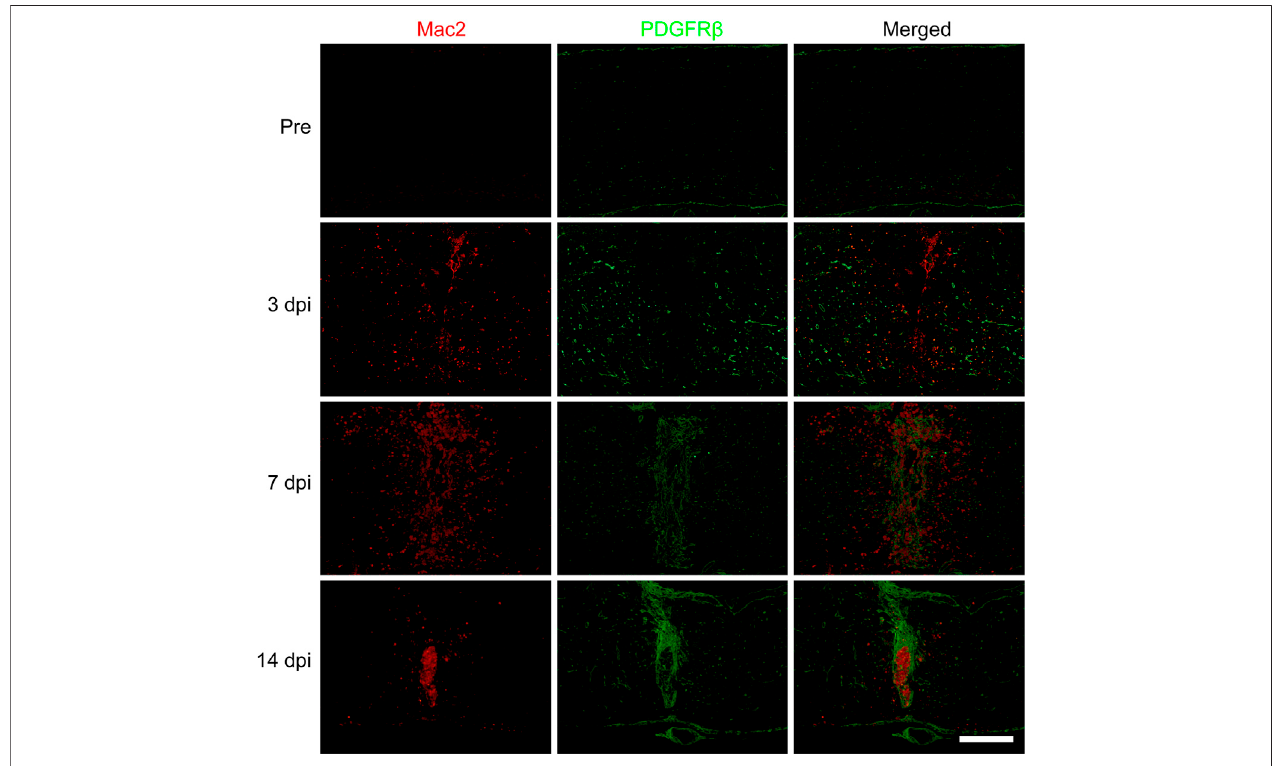
FIGURE 1 | Spatiotemporal distribution of macrophages and PDGFR β + pericytes after SCI in mice. Immuno fl uorescence staining was used to detect the distribution of macrophages (Mac2 + , red) and PDGFR β + pericytes (PDGFR β + , green) before (Pre) and at 3, 7, and 14 dpi in the injury core ( n (cid:2) 3 per group). Representative fl uorescence images were presented. Scale bars, 500 μ